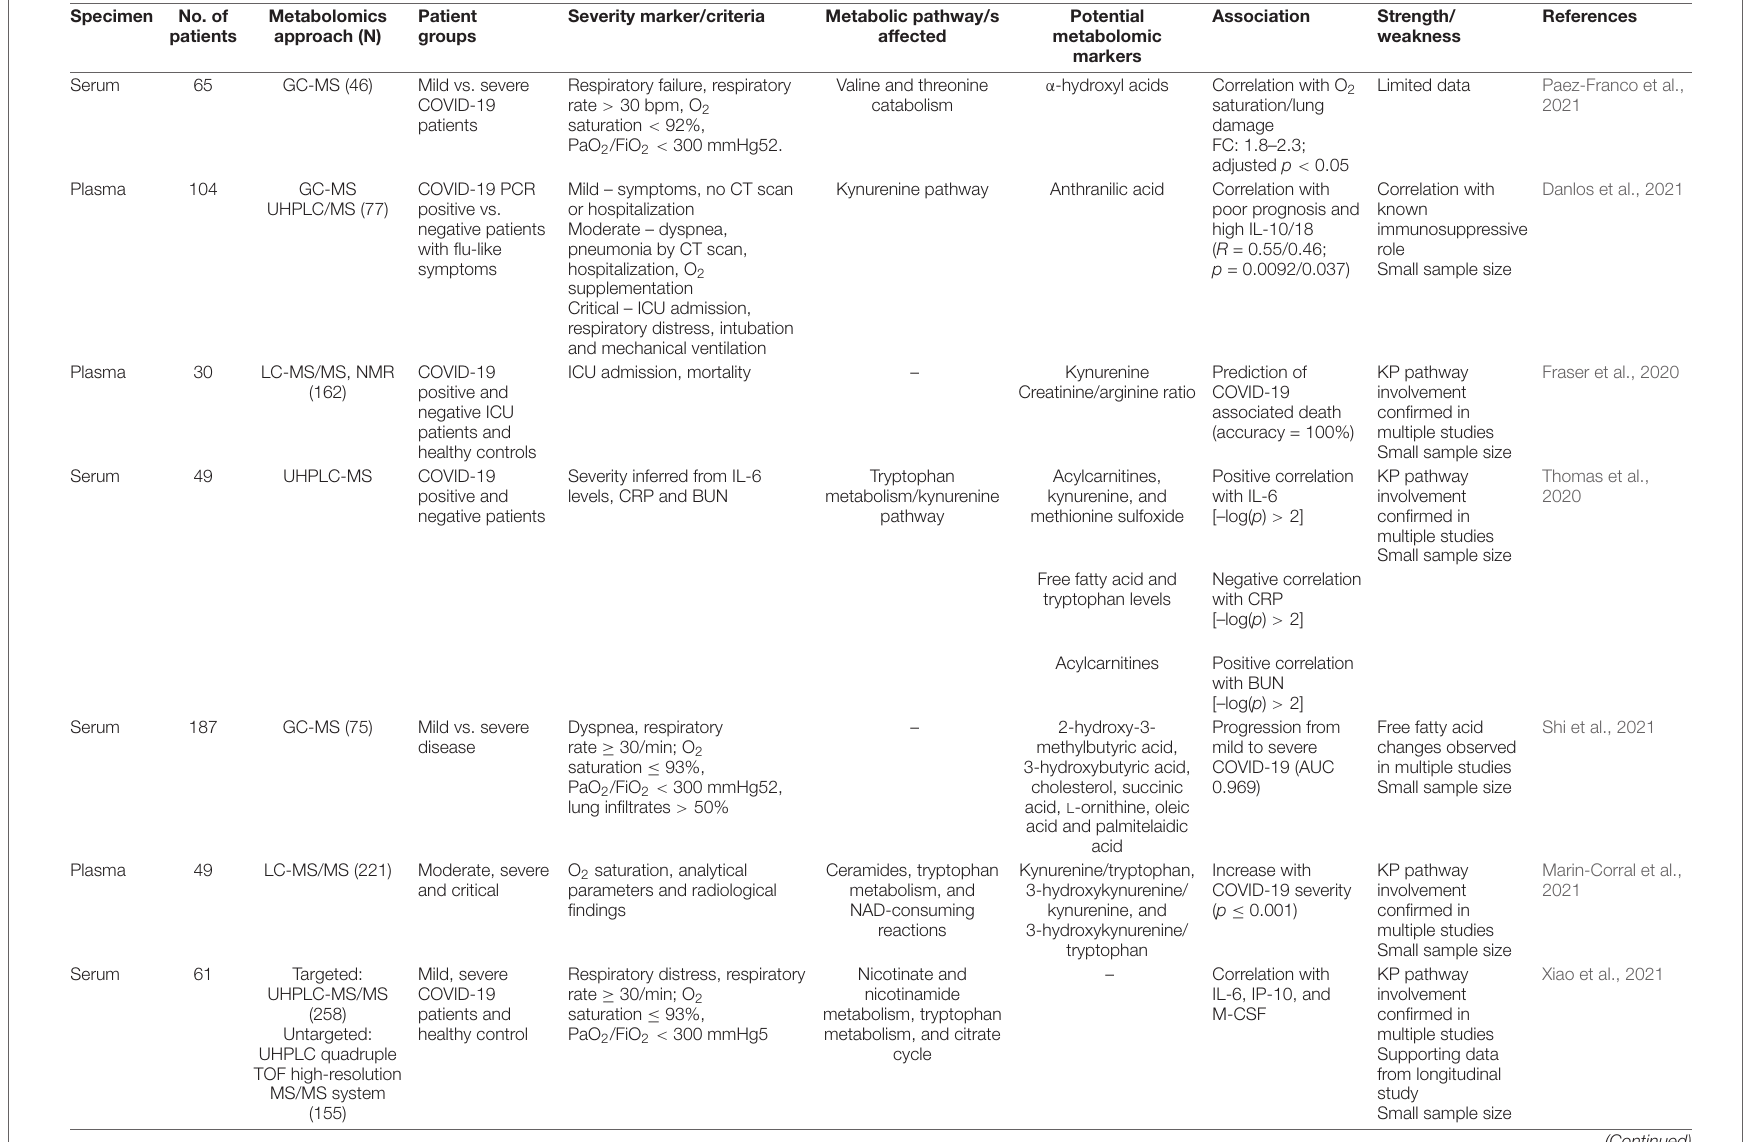
TABLE 3 | Metabolomics based potential prognostic markers for COVID-19. Specimen No. of